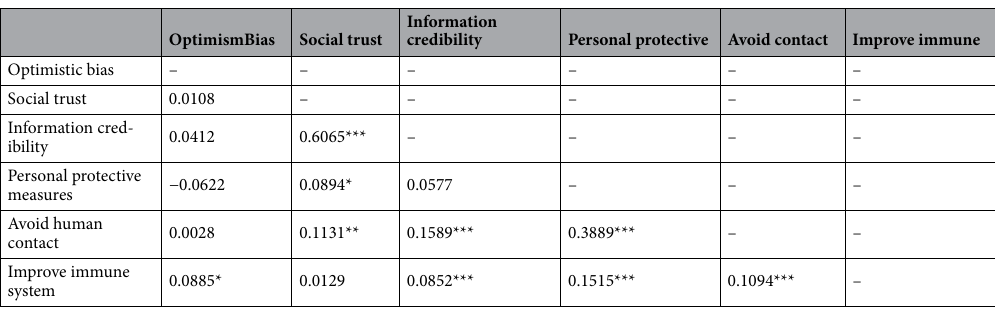
Table 3. Correlations of all variables. * p < .05, ** p < .01, *** p < .001.